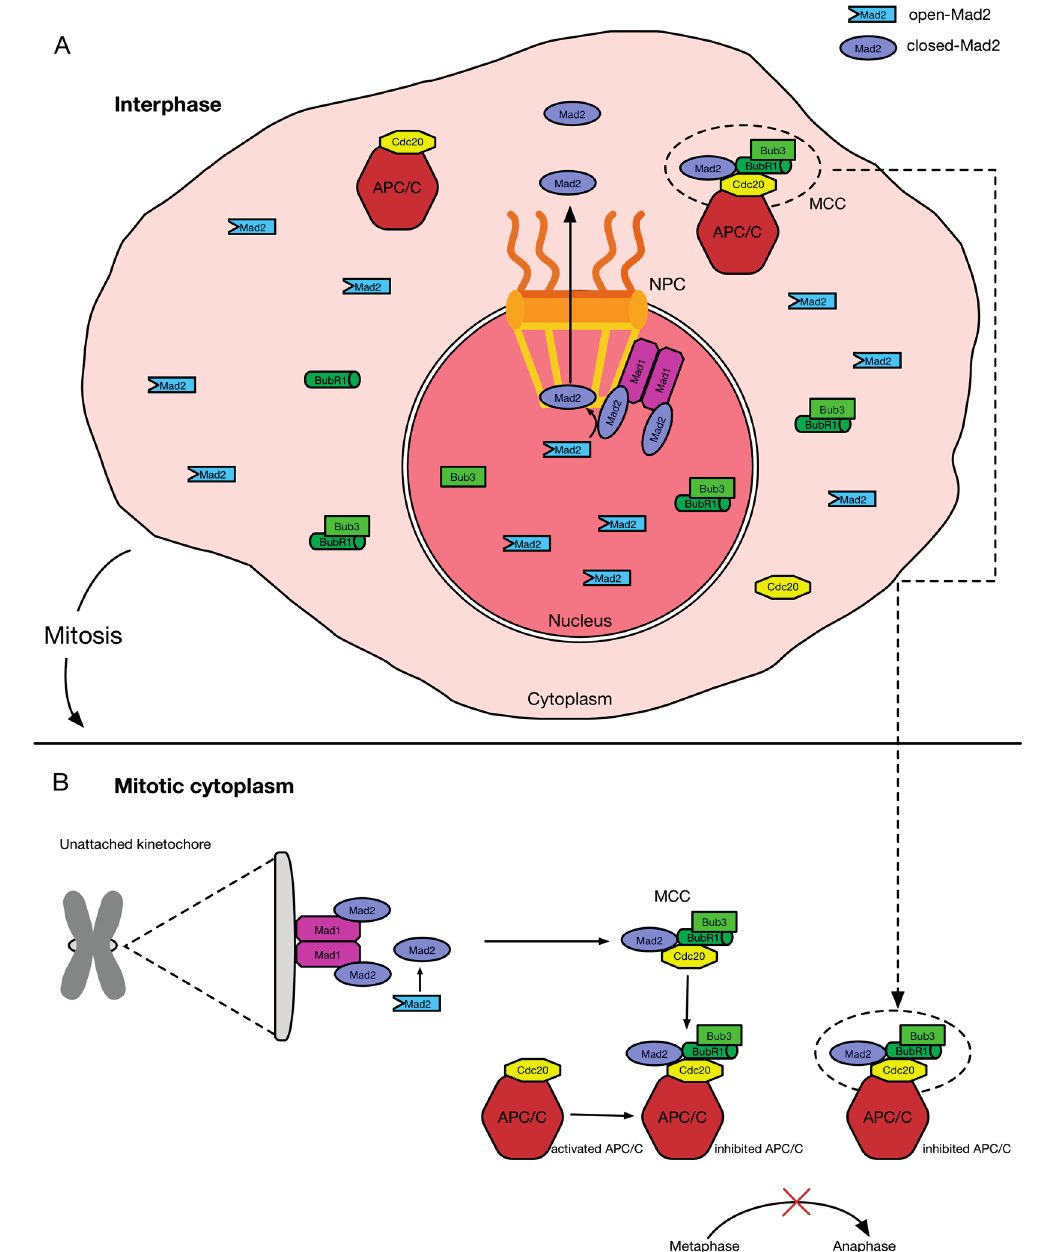
Figure 2. Schematic representation of MCC formation during interphase and mitosis. Mad1 and Mad2 form heterodimeric complexes in interphase and mitosis, which are localized to two distinct scaffolds: ( A ) the nuclear basket of NPCs; and ( B ) unattached kinetochores, respectively. The Mad1–Mad2 “core complex” provokes the conformational change of open-Mad2 (O-Mad2) to closed-Mad2 (C-Mad2). In this form, Mad2 binds to Cdc20 and with Bub3 and BubR1, it forms the MCC to inhibit the APC/C [143]. While unattached kinetochores catalyze the production of the MCC in mitosis, NPCs promote the production of the MCC in interphase [107]. In this way, Mad2 could be exported from the nucleus and translocated across the NPC after the induction of its conformational change to form the MCC in the cytoplasm [107]. These MCCs produced in interphase and in mitosis allow for the delay of anaphase onset and a more efficiency maintenance of the